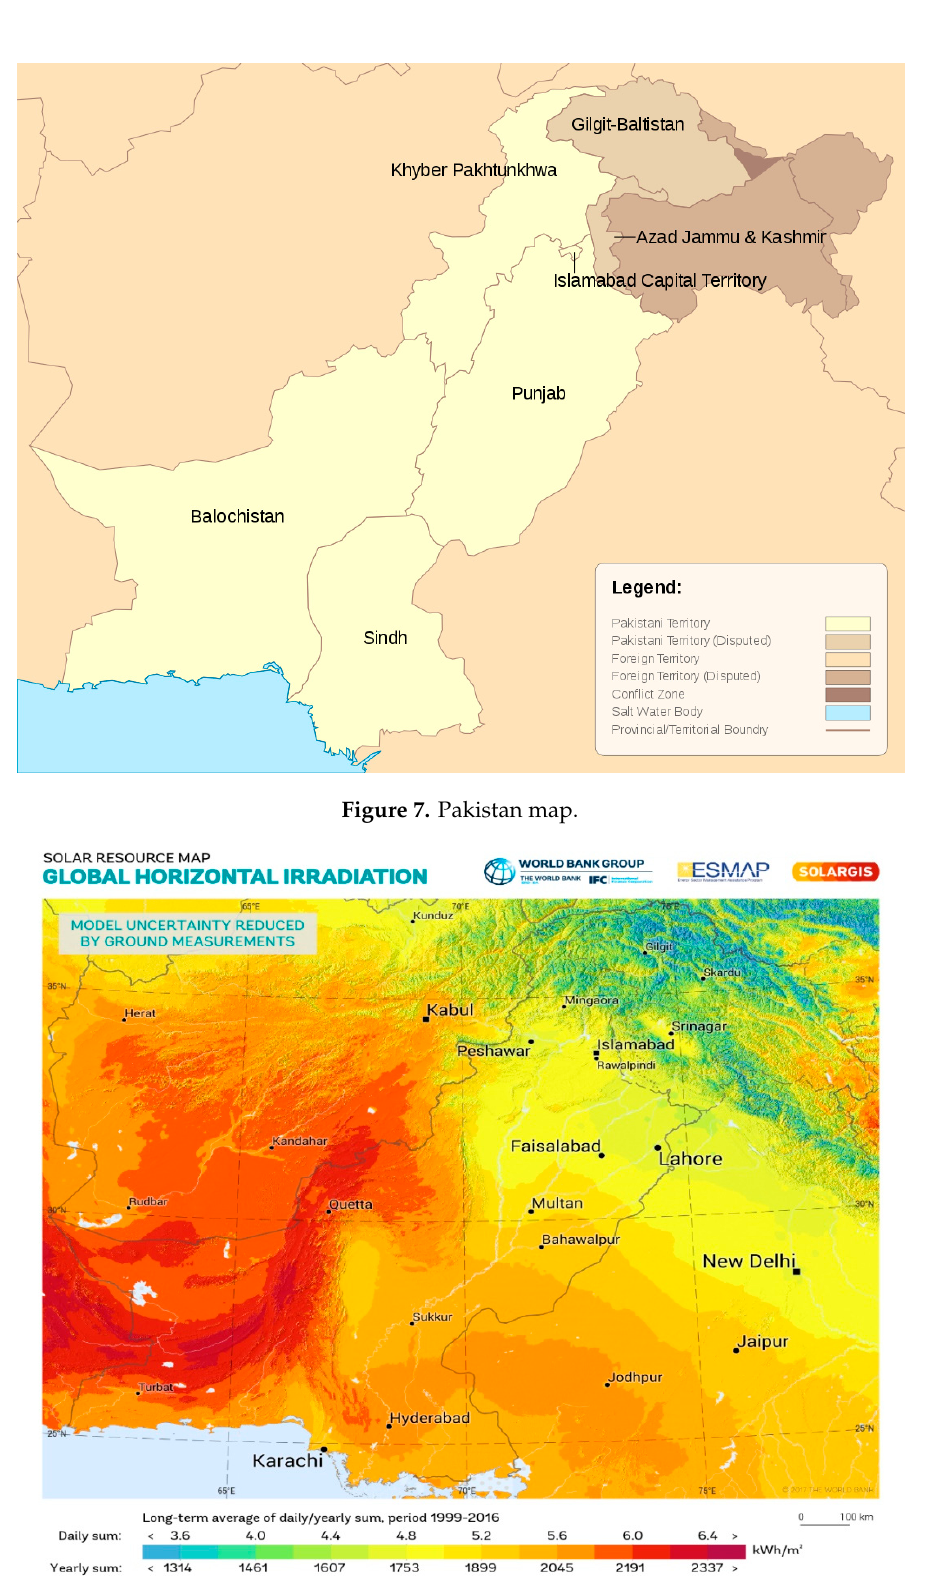
Figure 8. Annual global horizontal irradiation (GHI) in Pakistan.